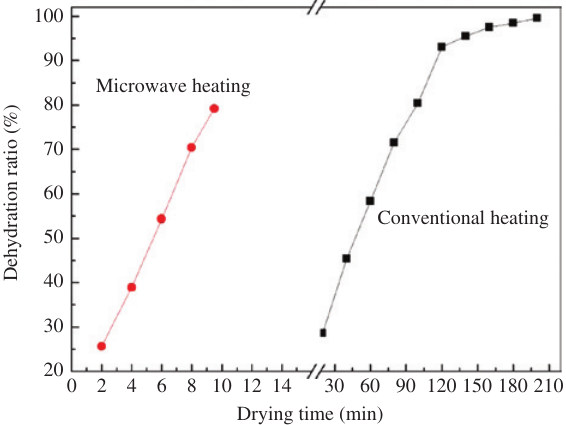
Figure 6: Effect of drying time on dehydration ratio using oven and microwave